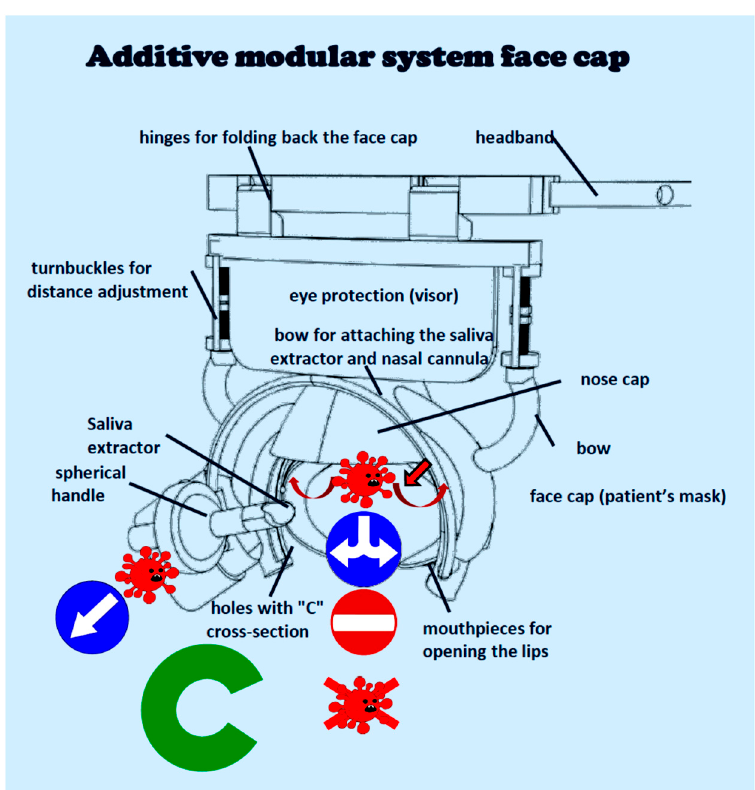
Figure 10. Diagram of the operation of the advanced face cap.